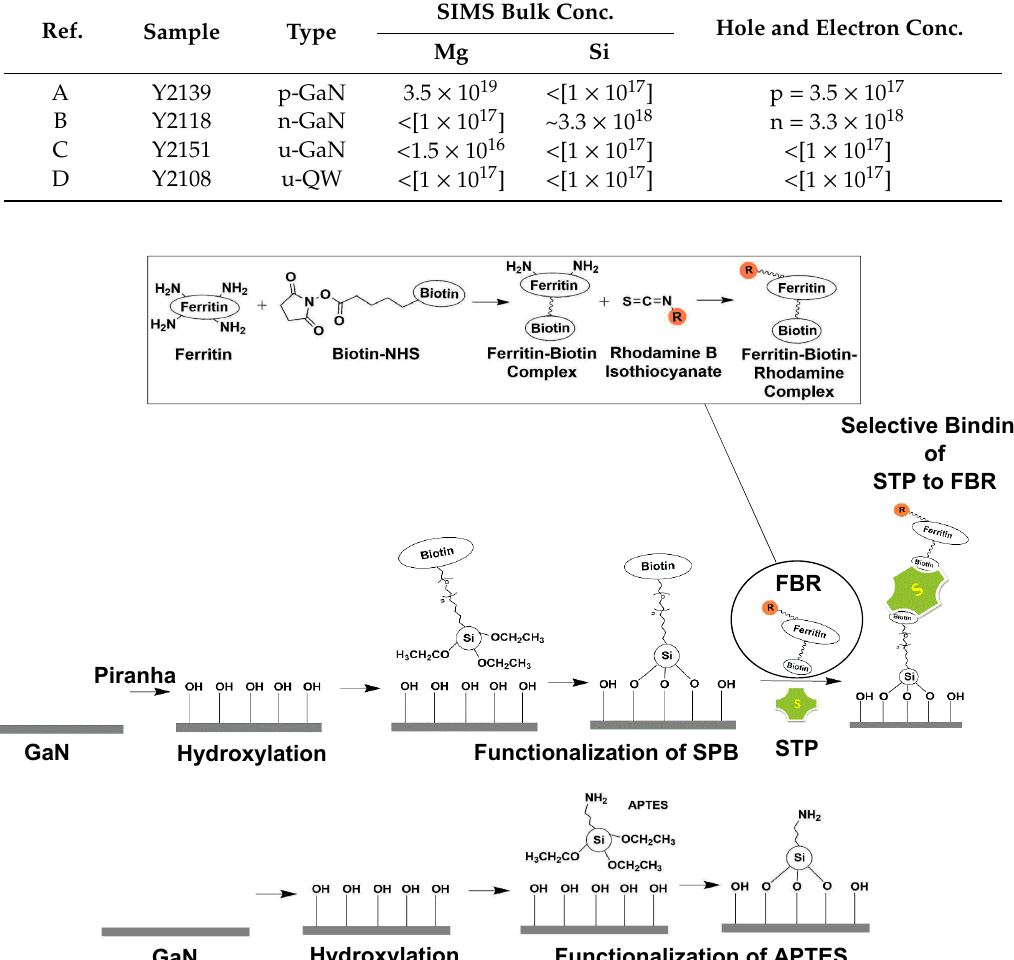
Figure 1. Schematic diagram illustrating the surface biomolecular functionalization routes performed to covalently link two kinds of silane molecules to the gallium nitride (GaN) surfaces, and the resulting protein immobilization. SPB: Silane-PEG-Biotin, STP: Streptavidin, FBR: Ferritin-Biotin-Rhodamine complex, APTES: (3-Aminopropyl) Table 1. Doping information of the samples: From the electron concentration of the n-doped samples from Hall measurements, we estimated the Si concentration, whereas both Mg and hole concentrations were measured (independently) for the Mg-doped samples using dynamic SIMS (secondary-ion mass spectrometry) and Hall measurements. Conc. in brackets means assumed concentration per cm 3 . p-GaN: p-type GaN, n-GaN: n-type GaN, u-GaN: un-doped GaN, un-doped GaN-GaInN (gallium indium nitride)-GaN quantum well structure.